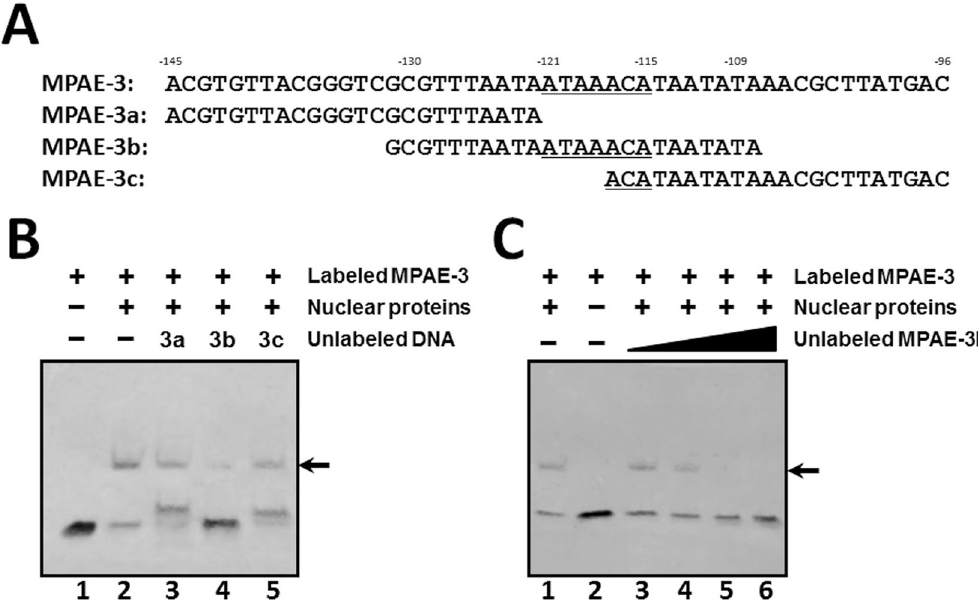
Figure 2. Binding of nuclear proteins from Sf9 cells to Fkh-binding site in MPAE-3. ( A ) DNA sequences of MPAE-3, MPAE-3a, − 3b and − 3c. Fkh-binding site is underlined. The numbers above the sequence indicate the positions upstream of the predicted transcription initiation site. ( B , C ) MPAE-3b competed binding of nuclear proteins to MPAE-3 fragment. Biotinylated MPAE-3 fragment alone (lane 1 in panel B and lane 2 in panel C) or incubated with nuclear proteins from Sf9 cells in the absence (lane 2 in panel B and lane 1 in panel C) or presence of excess (200-fold) unlabeled MPAE-3a, − 3b, or − 3c (lanes 3–5 in panel B), or in the presence of increasing amount of excess (1-, 10-, 100- and 200-fold) unlabeled MPAE-3b (lanes 3–6 in panel C), and EMSA assays were performed the same as in Fig. 1. Arrows indicated the mobility-shifted